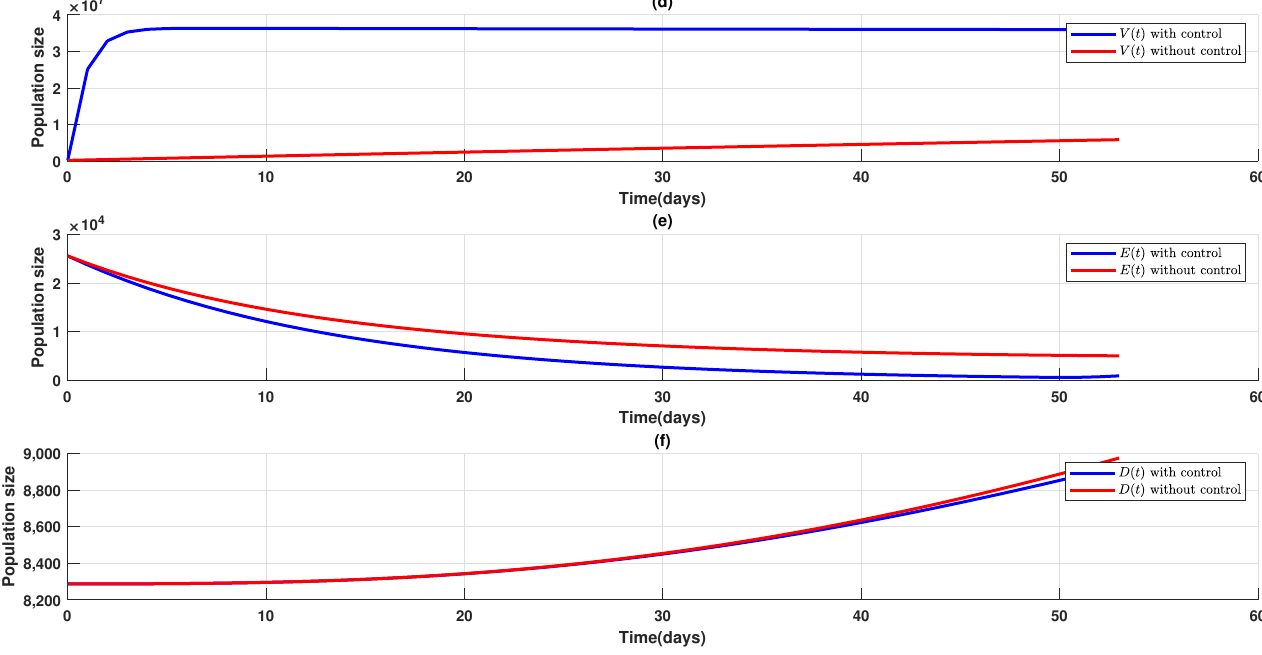
Figure 5. The time series of states V, E and D without and with